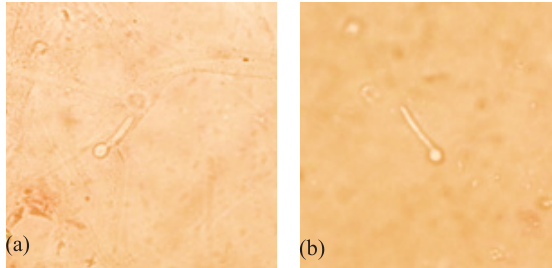
Figure1: Photomicrographs (×40) showing germ tube production in tomato juice (a) and in human serum